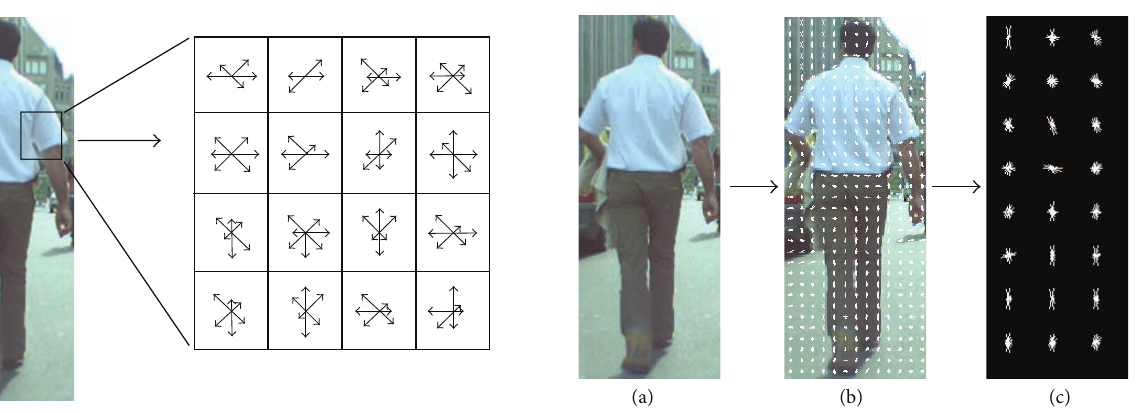
Figure 4: Extraction process of HOG features. The HOG features are extracted from local regions with 16 × 16 pixels. Histograms of edge gradients with 8 orientations are calculated from each of the 4 × 4 local cells.